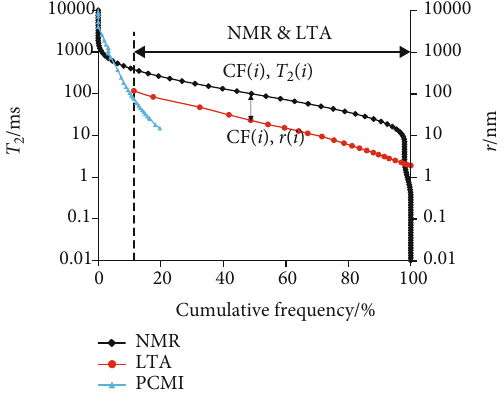
Figure 6: Data selection of conversion from T distributions with three